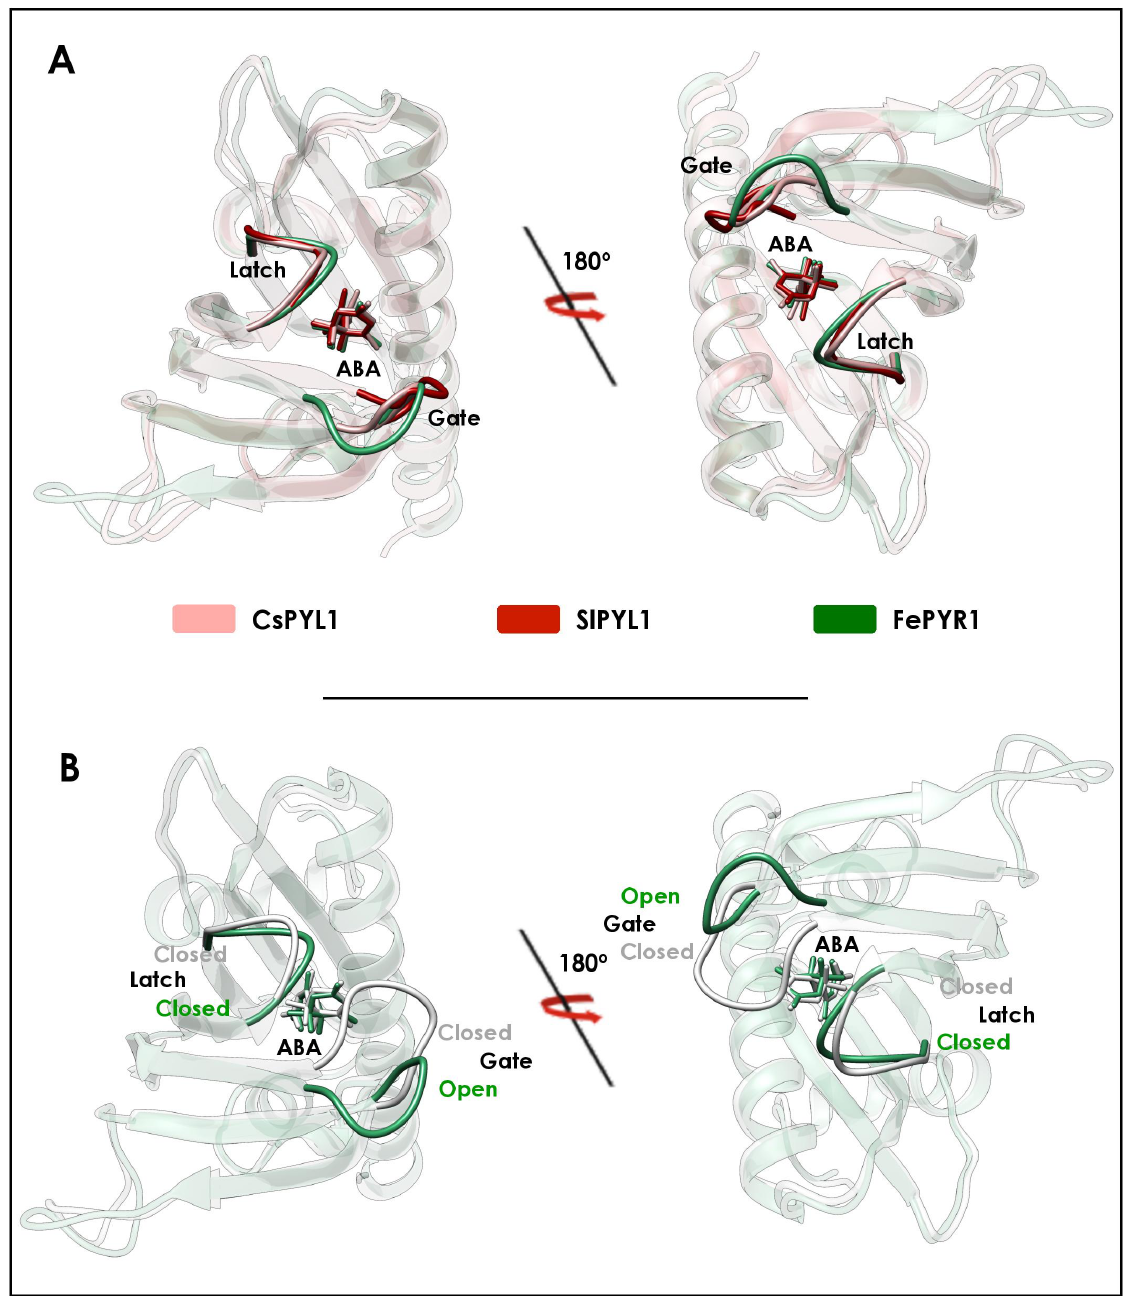
Figure 5. The latch-closed/gate-open ABA-bound intermediate. ( A ) Structural alignment of a latch-closed/gate-open ABA-bound conformation of citrus PYL1 (CsPYL1) (PDB ID: 5MMX), tomato PYL1 (SlPYL1) (PDB ID: 5MOB) and PYR1 from turfgrass (FePYR1) (PDB ID: 5UJV). Latch and gate are highlighted in solid colors. ( B ) Superimposition of the latch- closed/gate-open and latch-closed/gate-closed ABA-bound molecules from FePYR1 crystal structure (PDB ID: 5UJV). Latch and gate are highlighted in solid colors.